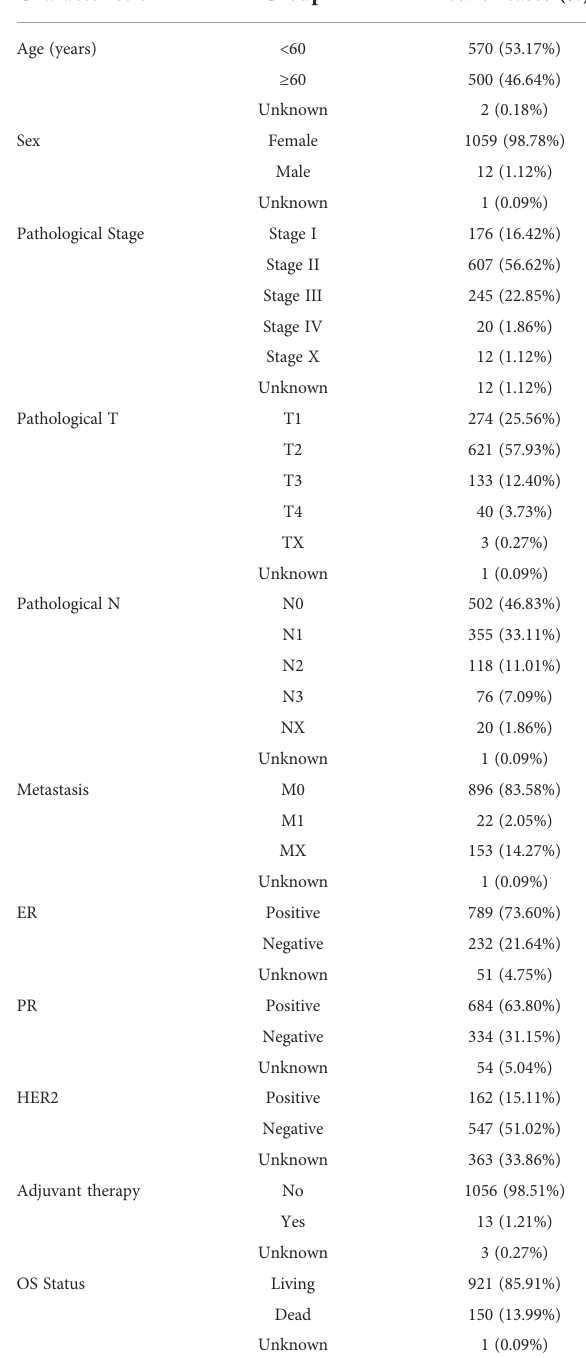
TABLE 1 Clinical pathological characteristics of extracted BRCA